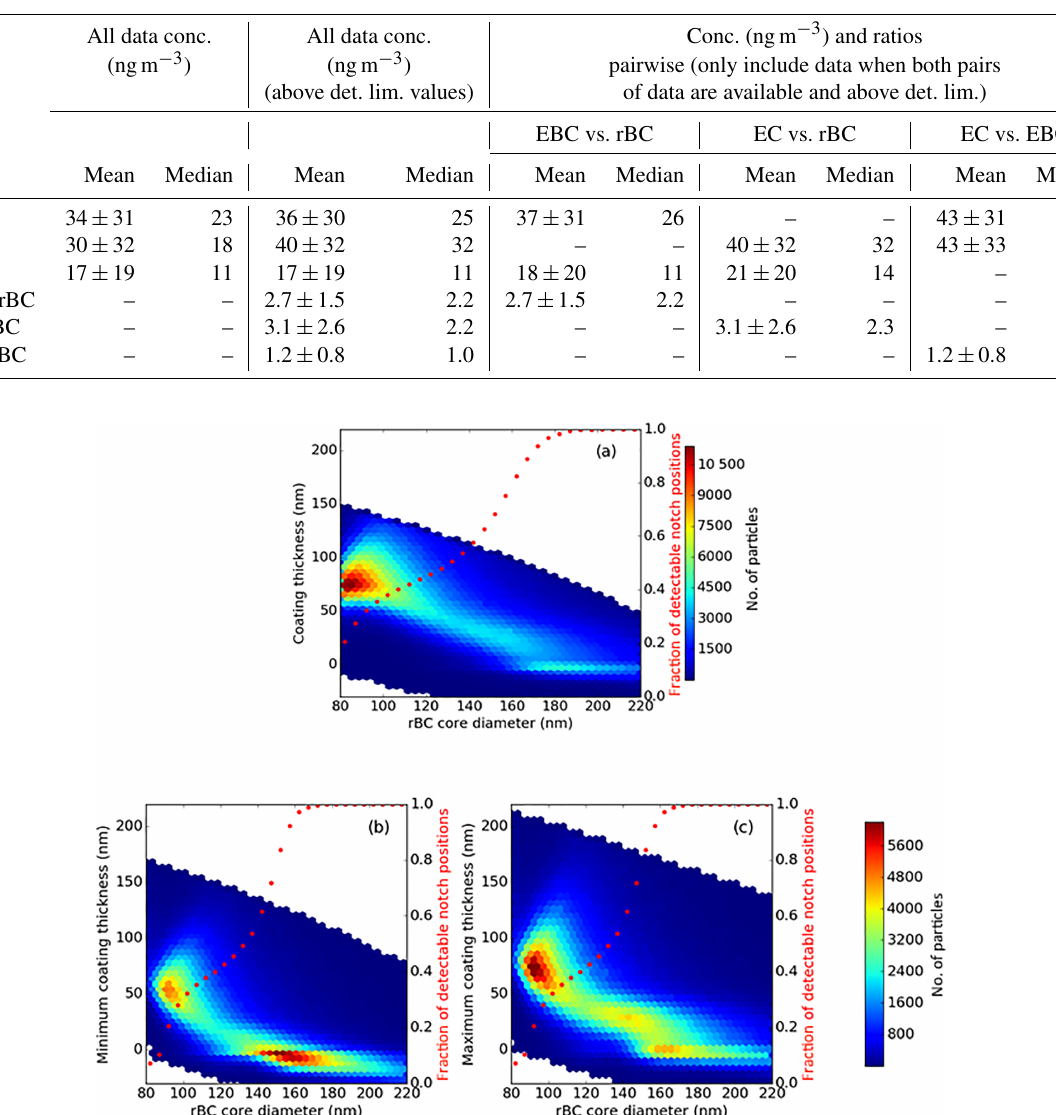
Figure 6. Two-dimensional histograms of coating thickness as a function of core size for rBC particles in Alert, NU: (a) the average coating thickness during April 2012, (b) the minimum coating thickness during October and November 2013, and (c) the maximum minimum coating thickness during October and November 2013. The red circles indicate what fraction of rBC cores at each size could be successfully assigned a coating thickness. Negative coating thickness indicates that the measured scattering for a particle is less than the Mie calculations predict for an rBC particle of that diameter with zero coating. These values arise from the inherent noise in the data, assumptions made about the rBC and coating refractive indices, and particle